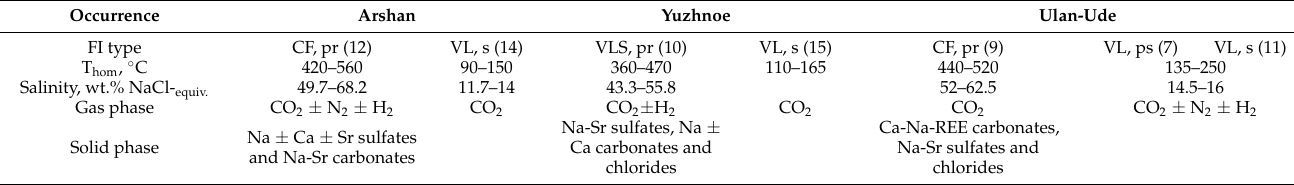
Table 2. Fluid inclusions in fluorites from Arshan, Yuzhnoe and Ulan-Ude